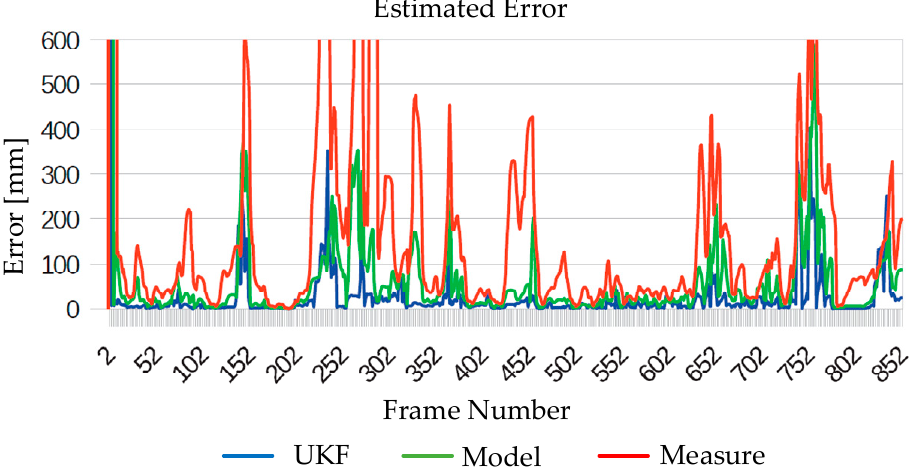
Figure 14. Comparison of the error of the estimated UKF with the errors of the motion model and the measure mode.